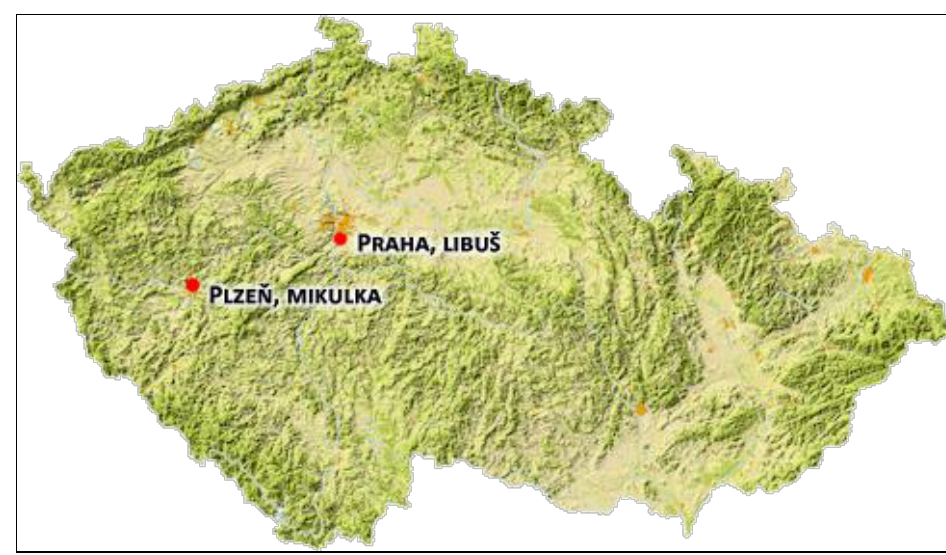
Fig. 1. Automated EWM evaporimeter at the weather station in Prague-Libuš (source: CHMI)